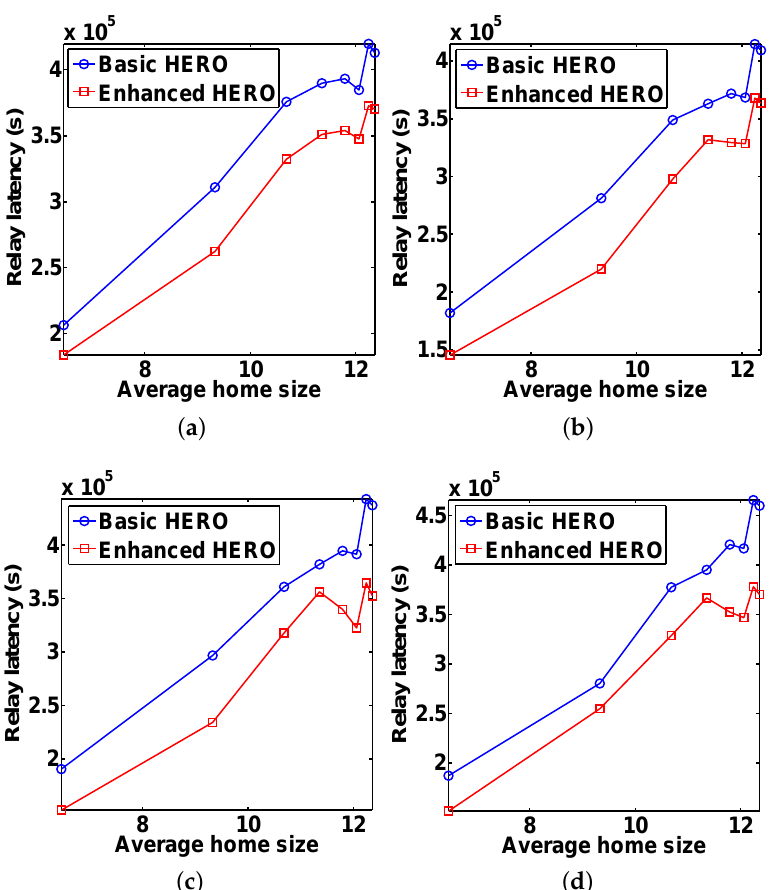
Figure 7. The impact of home size on the average relay latency, which shows that the relay latencies of enhanced HERO are better than those of basic HERO in all scenarios. ( a ) U = 300; ( b ) U = 400; ( c ) U = 500; ( d ) U =